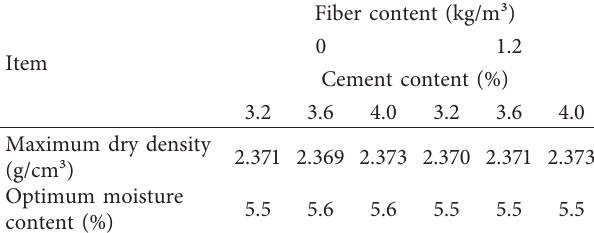
Table 5: Maximum dry density and optimum moisture content.